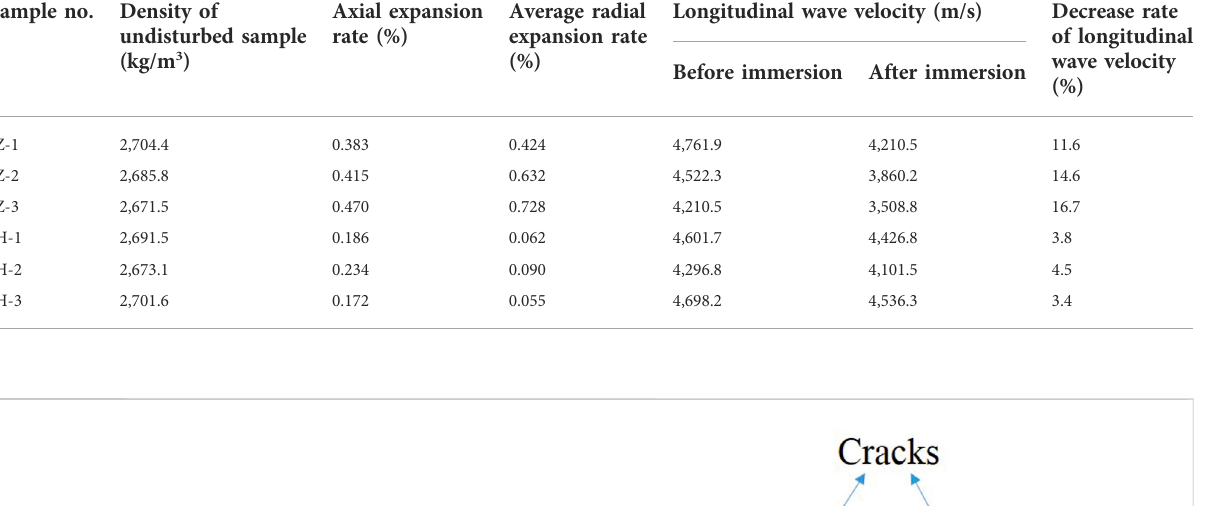
TABLE 1 Test results of expansion rate and longitudinal wave velocity. Sample no.